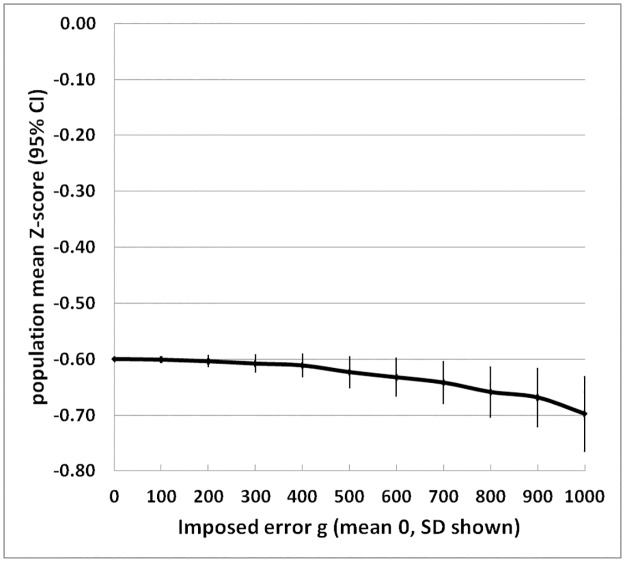
Change in the population mean Z-score from 50 simulated surveys with an initial mean of -0.6 Z, with imposed measurement errors in weight.Error bars show 95% confidence intervals.